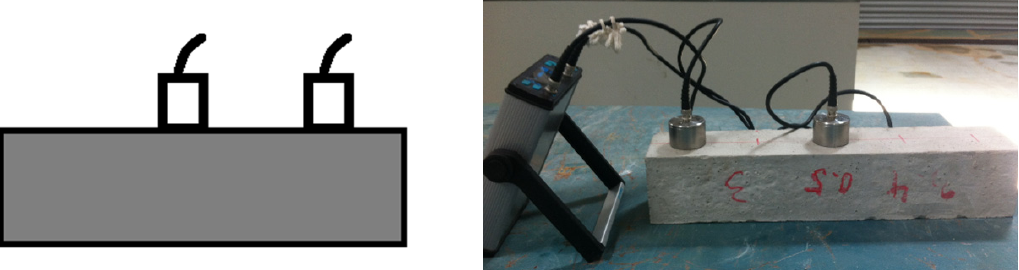
Figure 6. Indirect UPV measurement.